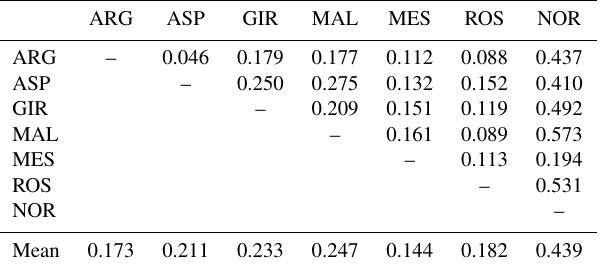
Table 3. Number of inferred haplotypes ( f ≥ 1%) per breed and gene, percentage of private haplotypes (% PH), and percentage of haplotypes shared among all seven goat breeds (% SH7).